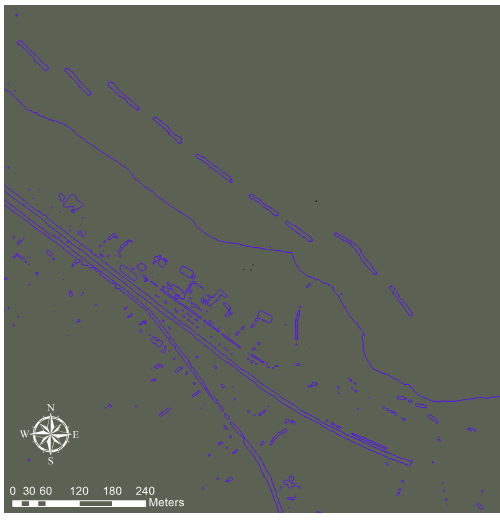
Figure 2. J-Net algorithm tested on NIR2 band of the WorldView-2